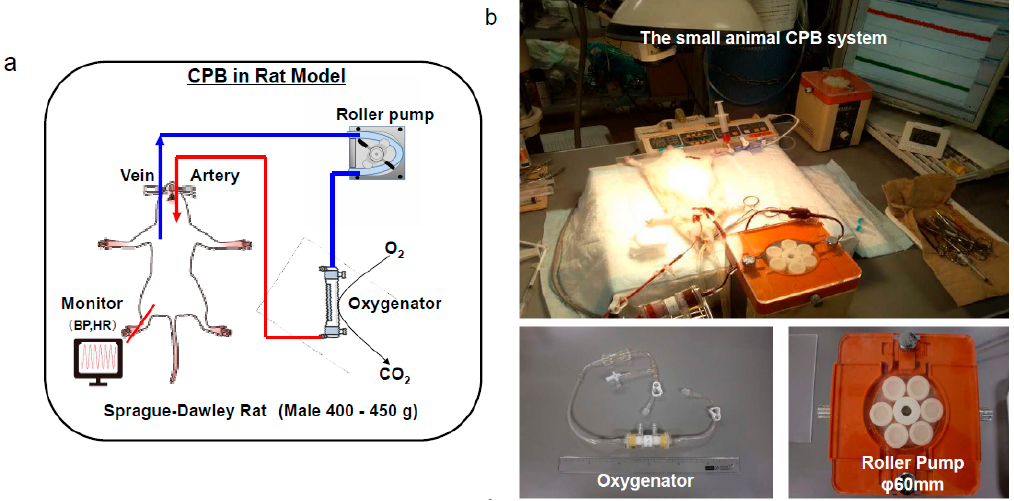
Figure 2. The small animal cardiopulmonary bypass (CPB) model. A polypropylene membranous oxygenator with a membrane area of 0.03 m 2 , a polyvinyl chloride tubing line, and a roller pump are shown [28]. ( a ), schema, ( b ), actual situation.